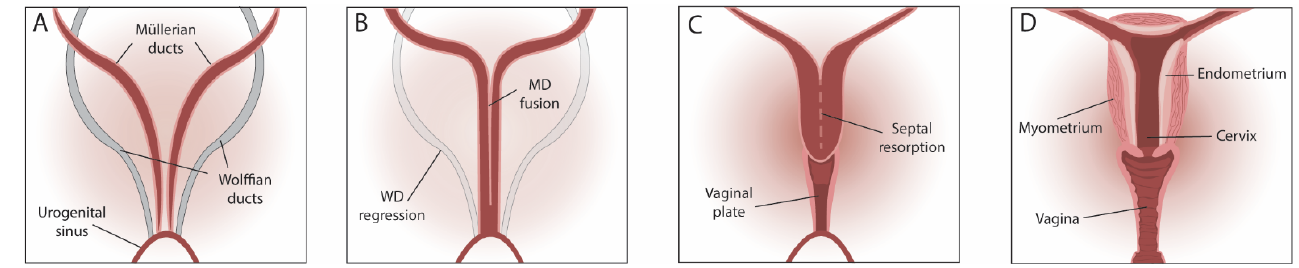
Figure 2. Embryonic development of the female reproductive tract. ( A ) Müllerian duct (MD) and Wolffian duct (WD) formation. ( B ) MD fusion and WD regression. ( C ) Septal resorption in the fused MDs. ( D ) Developed uterus with myometrium and endometrium.